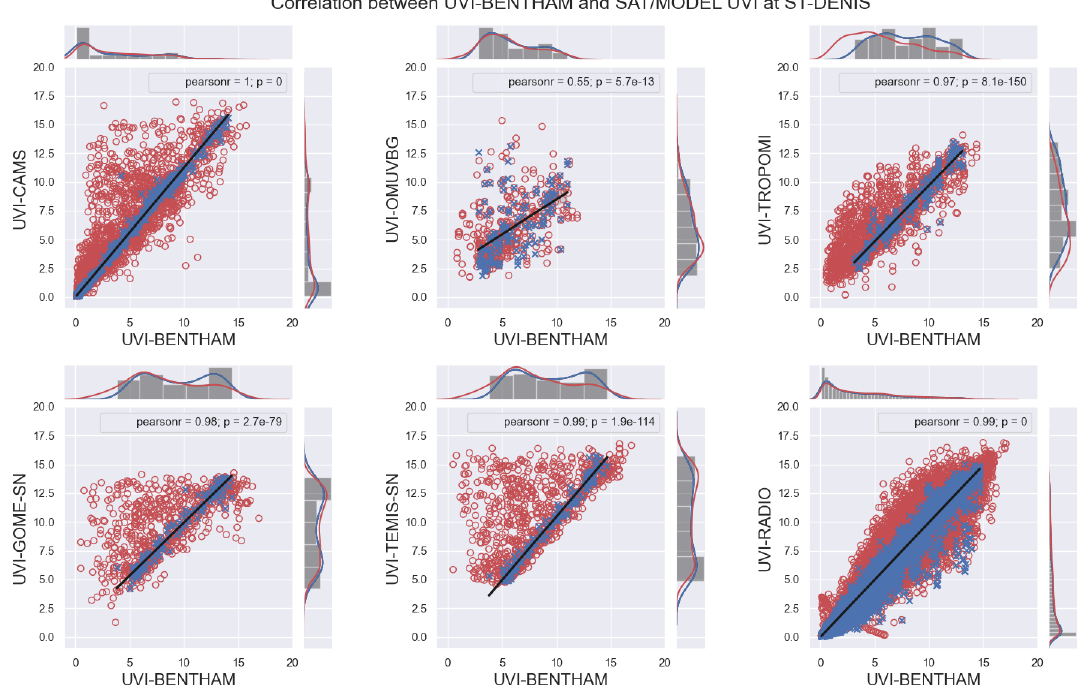
Figure A1. Correlation between UVI-BENTHAM and satellite/model estimates at Saint-Denis. A histogram representing each dataset distribution is represented at the right and at the top side of each subfigure. The clear-sky measurements made by UVI-RADIO have been distinguished and are shown as blue crosses, while the measurements for all-sky conditions are shown as red circles.